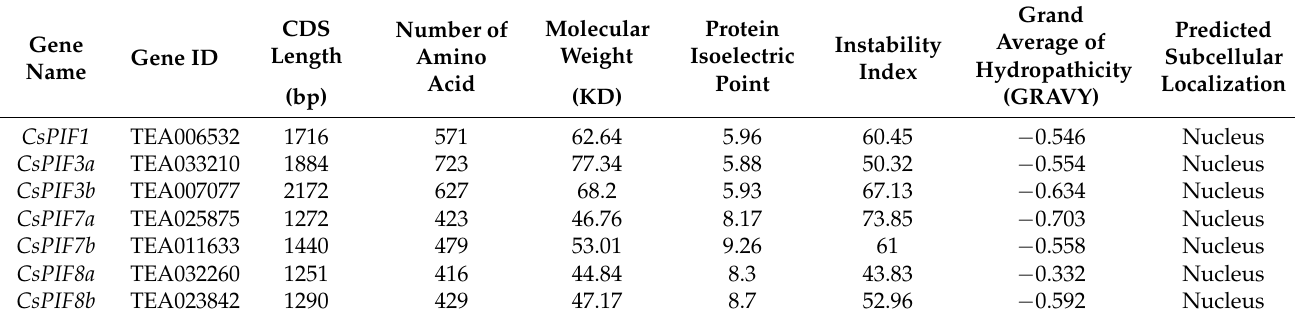
Table 1. The physiological and biochemical characterization of seven PIF proteins in tea